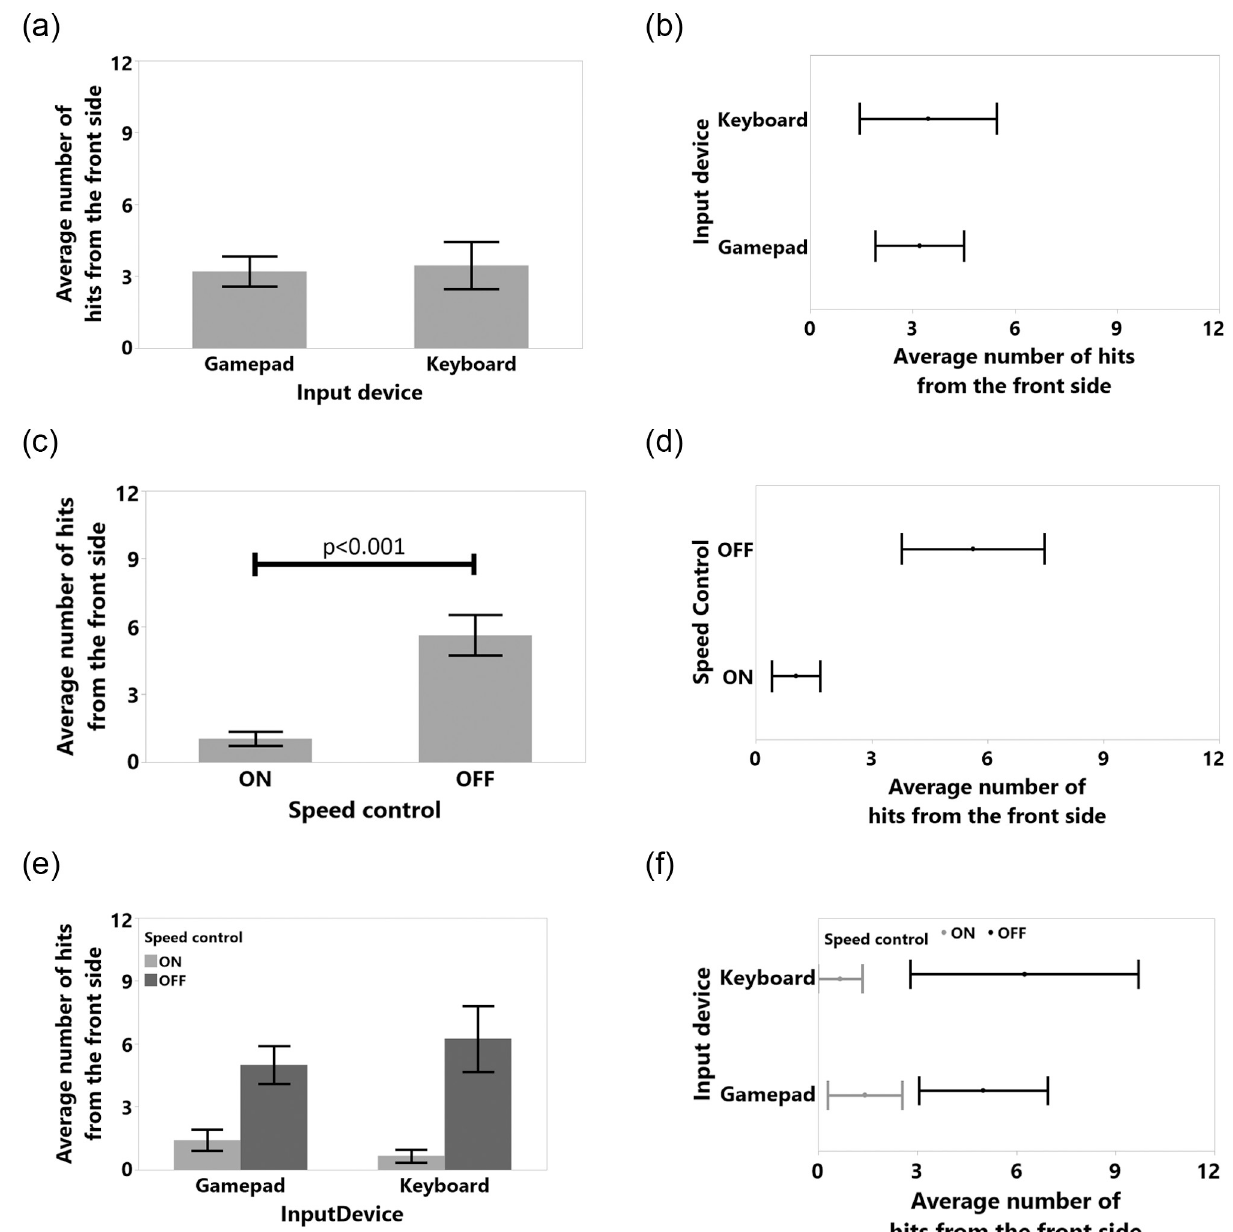
Fig 10. Average number of hits from the front side and standard error of means for (a) input device, (c) speed control, (e) input device and speed control interaction. Means and %95 confidence intervals for number of hits from the front side for (b) input device, (d) speed control, (f) input device and speed control